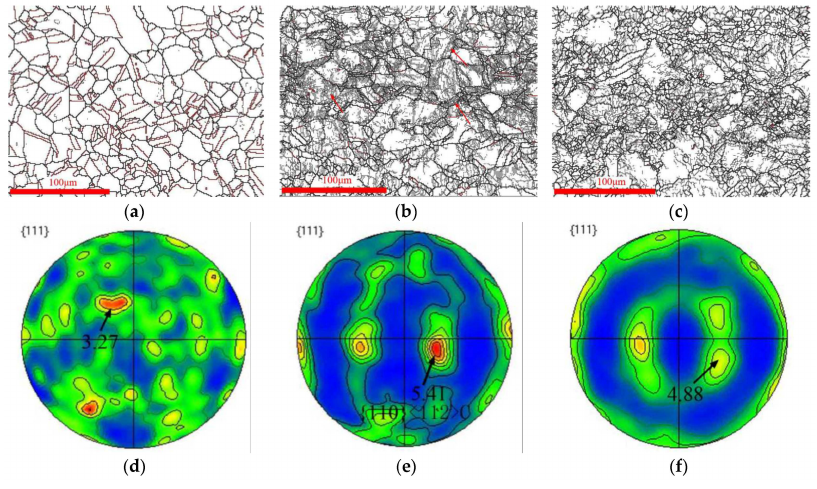
Figure 5. Microstructure and pole maps under different cold rolling reduction ( a )/( d ) ε = 0% ( b )/( e ) ε = 30% ( c )/( f ) ε =